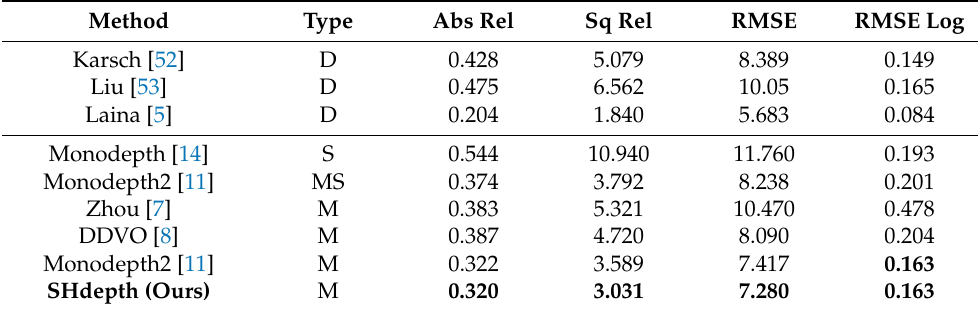
Table 5. Make3D results. Best results in each category are in bold. D—depth supervision, S—self- supervised stereo supervision, M—self-supervised mono supervision, MS—self-supervised mono and stereo supervision. All M methods use the median scaling and the MS method predicts the depth by the unmodified